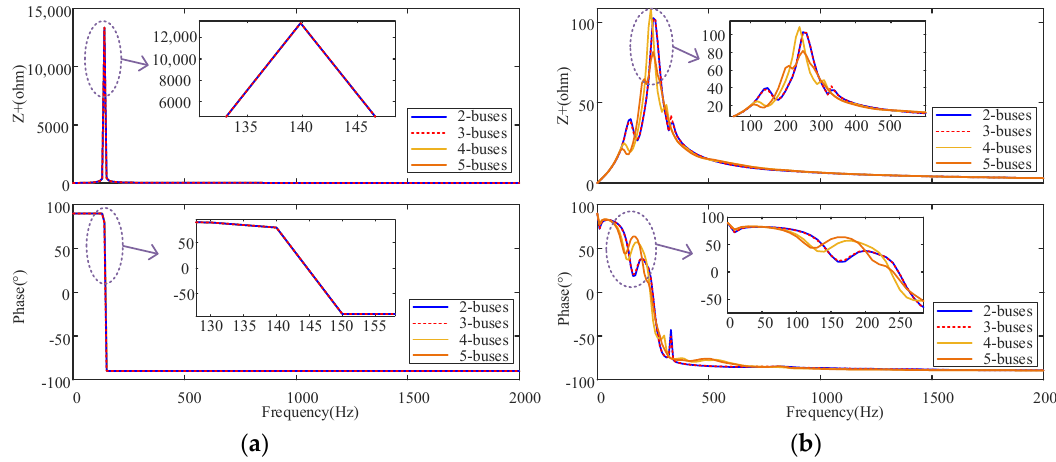
Figure 6. ( a ) Impedance-frequency characteristic of the rectifier-side bus 301; ( b ) Impedance-frequency characteristic of the inverter-side bus 55.